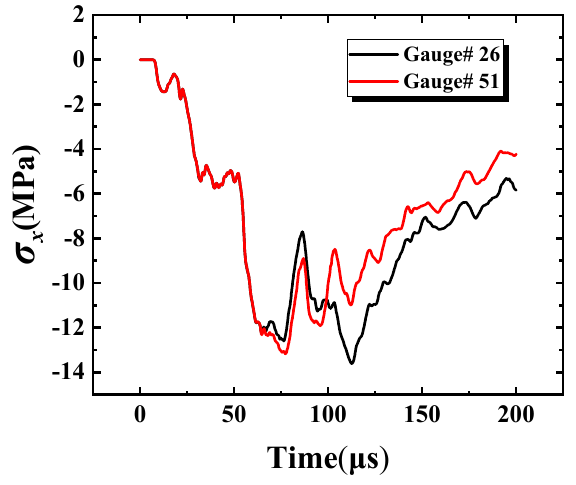
Figure 2. Symmetrical measurement point stress change of disc specimens.